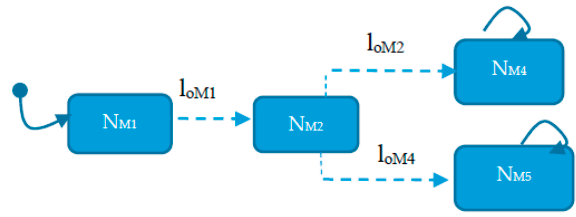
Figure 5. An example of reduced machine model.